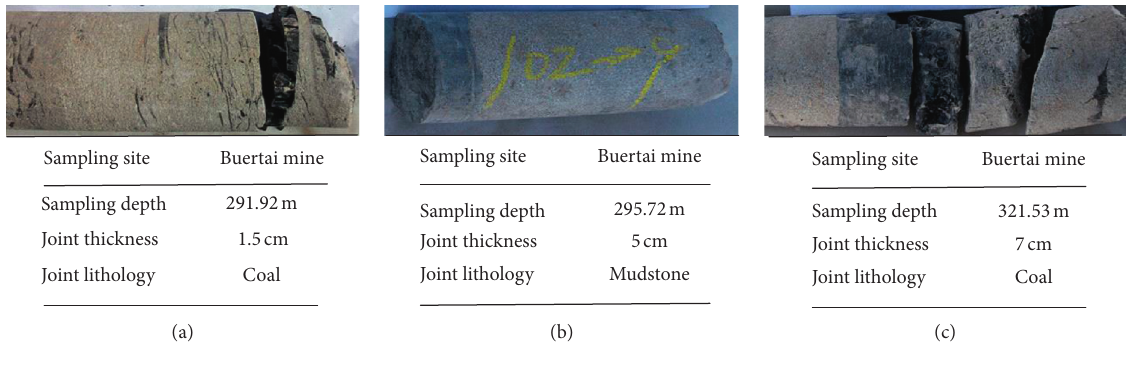
Figure 1: Example siltstone planes with different joint